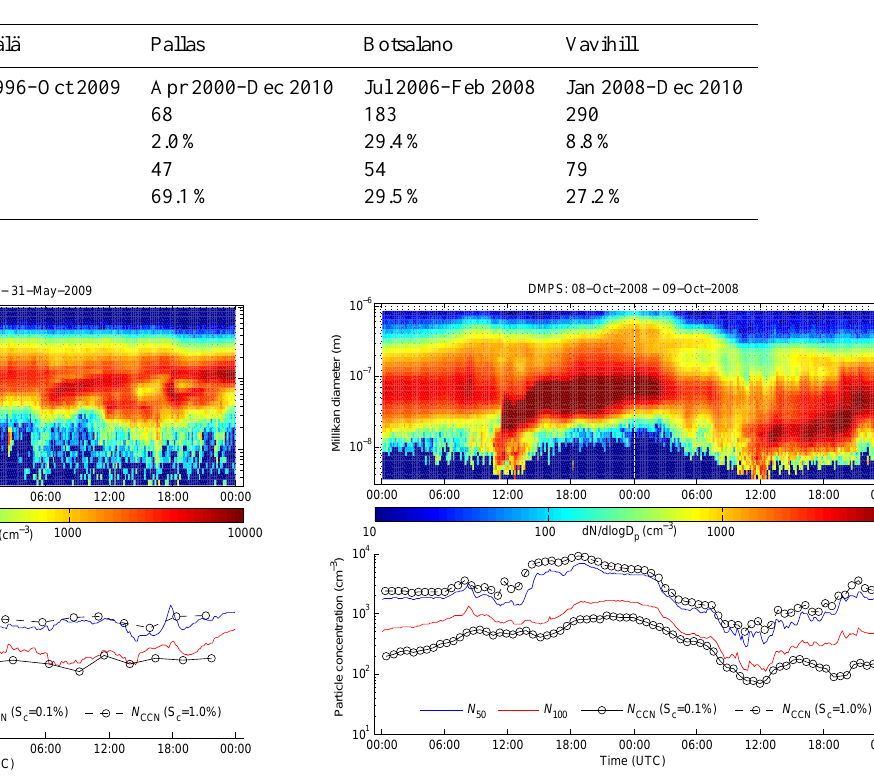
Fig. 4. An example of a nucleation event in Vavihill station on Octo- ber 8. 2008. The top panel depicts the time series of particle number size distribution. The bottom panel shows the corresponding time series of two DMPS-derived CCN concentrations ( N 50 and N 100 ) and two CCN concentrations N CCN measured by the CCNC at two supersaturation ( S c ) levels of 0.1% and 1.0%.